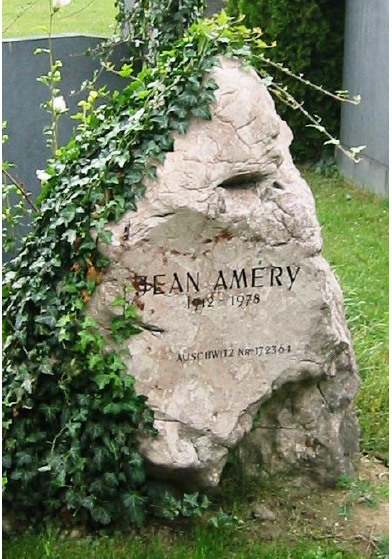
Figure 1. Grave of Jean Améry at the Zentralfriedhof Vienna. Photography by Invisigoth67 under a CC BY-SA 2.5 license (https://en.wikipedia.org/wiki/Jean_Am